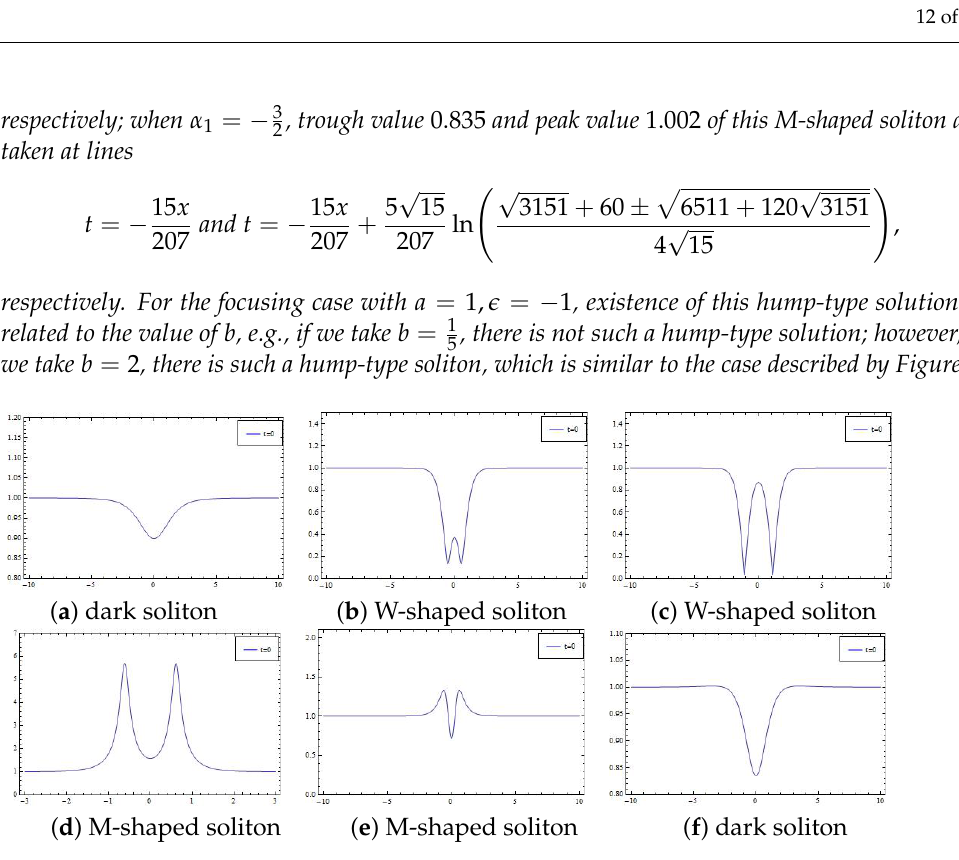
Figure 6. Soliton solutions for Equation (5) with d 12 = i, d 13 = 2, (cid:101) = 1, a = 1, b = 1 with α 1 = 3 , ( b ) W-shaped soliton with α 1 = 1 2 , ( e ) M-shaped soliton with α 1 = − 7 soliton with α 1 = − 1 2